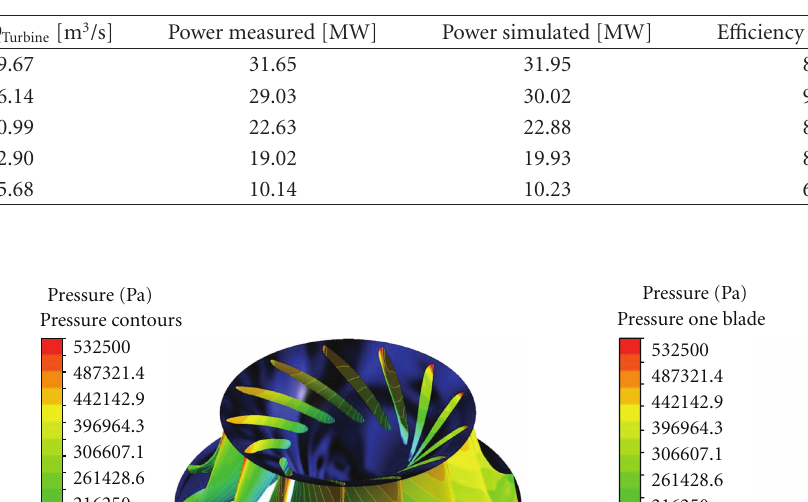
Table 3: Comparison between numerical and experimental data.